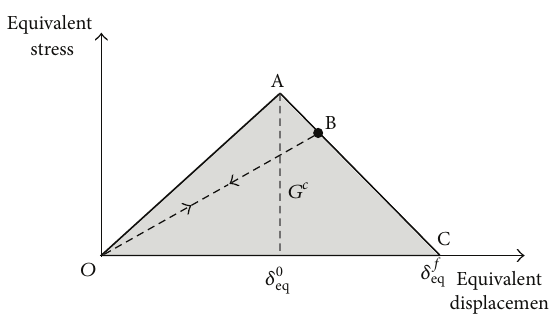
Figure 4: Linear damage